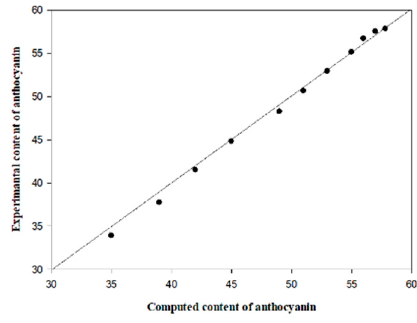
Figure 14. A comparison between the simulated and experimental anthocyanin content.